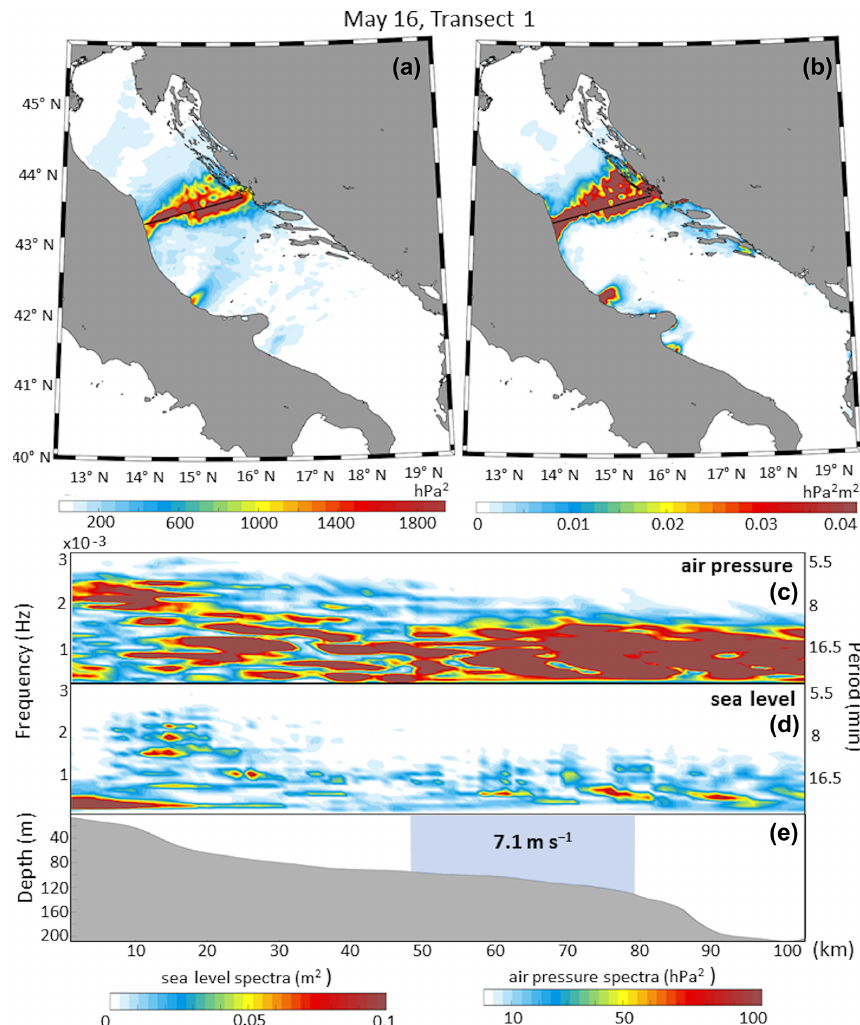
Figure 10. As in Fig. 7, but for the meteotsunamigenic disturbance of 16 May 2020 along Transect